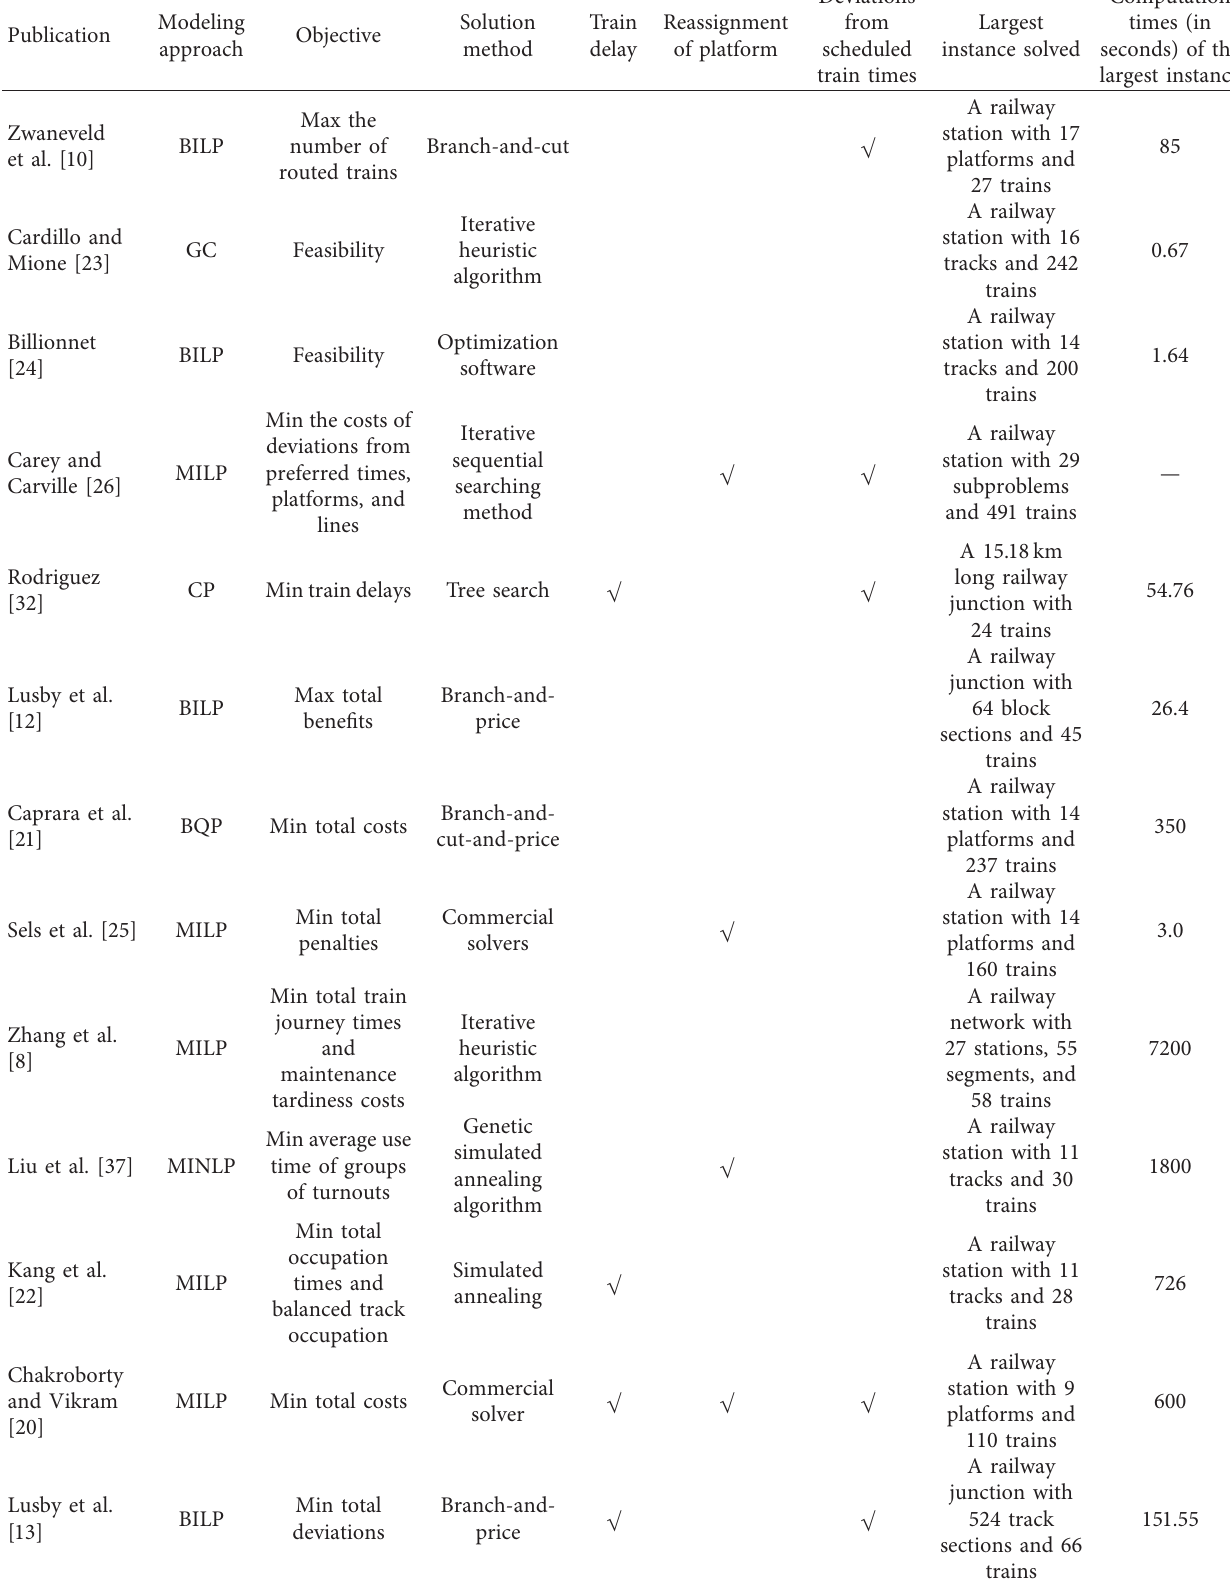
Table 1: Summary of relevant publications on the optimization and reoptimization of the train platforming